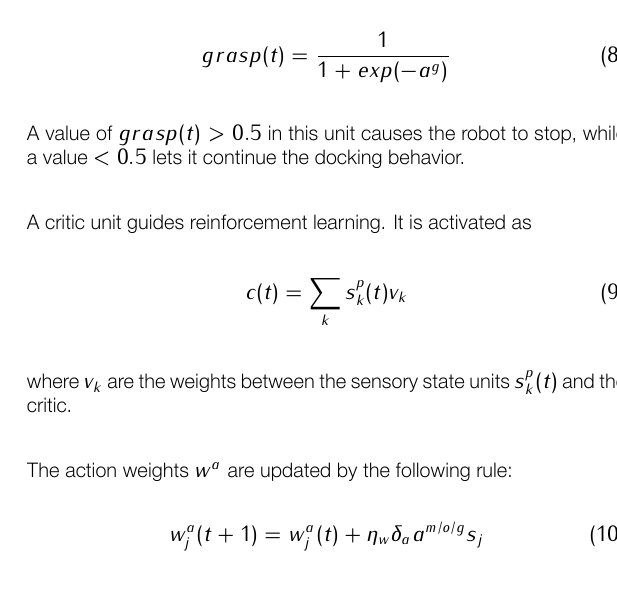
s b ( t ) denotes the state of input neuron i at the t -th time-step. The i activations of the hidden units y j at time t are defined as N 1 × N 2 × N 3 ∑ y j ( t ) = where u I represents the weight matrix between input layer and hid- ji den layer, ¯ u I represents the weight matrix between the time-delayed ji input and the hidden layer and u R indicates the recurrent weight ma- jj ′ trix within the hidden layer. The above equation shows that the hidden layer is connected to the weighted stimuli of the current input and de- layed input, while there are additional lateral